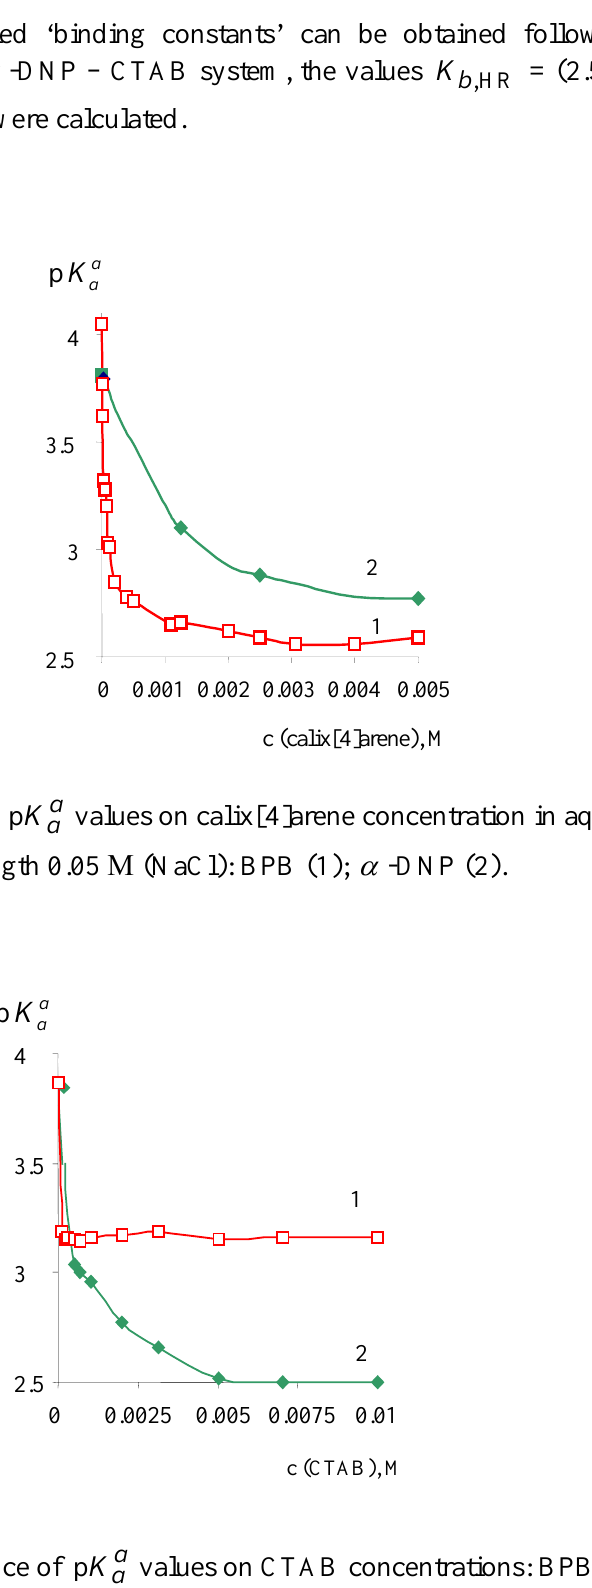
K p values on CTAB concentrations: BPB, ionic Figure 4. The dependence of a a strength: 0.1 M, KBr (1); α -DNP, ionic strength 0.05 M, KBr